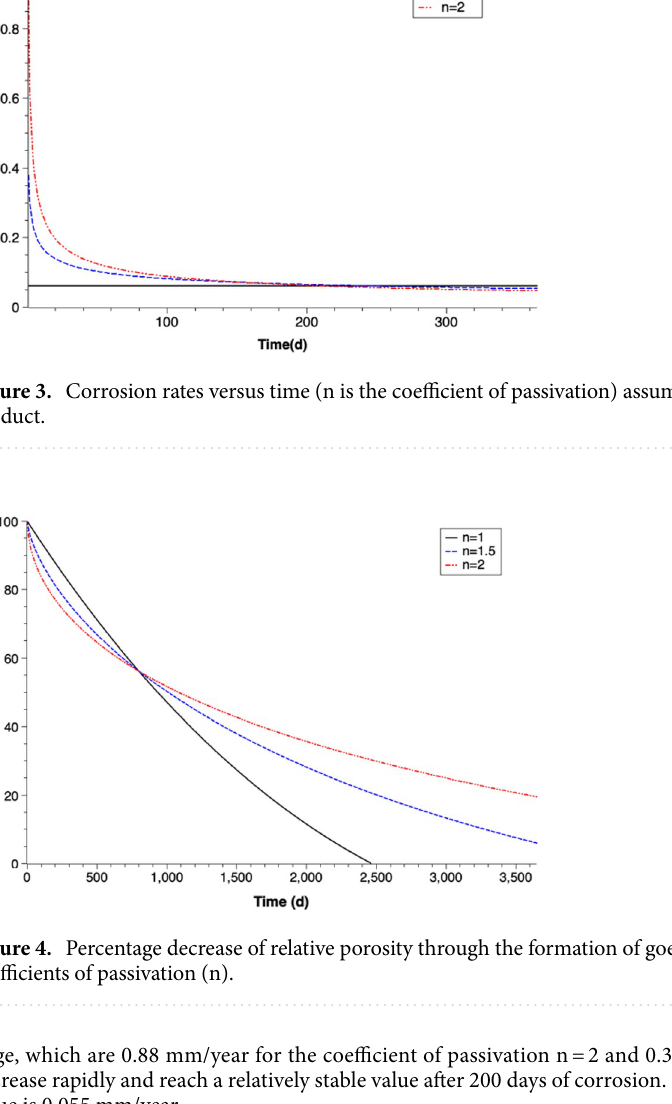
Relative porosity =